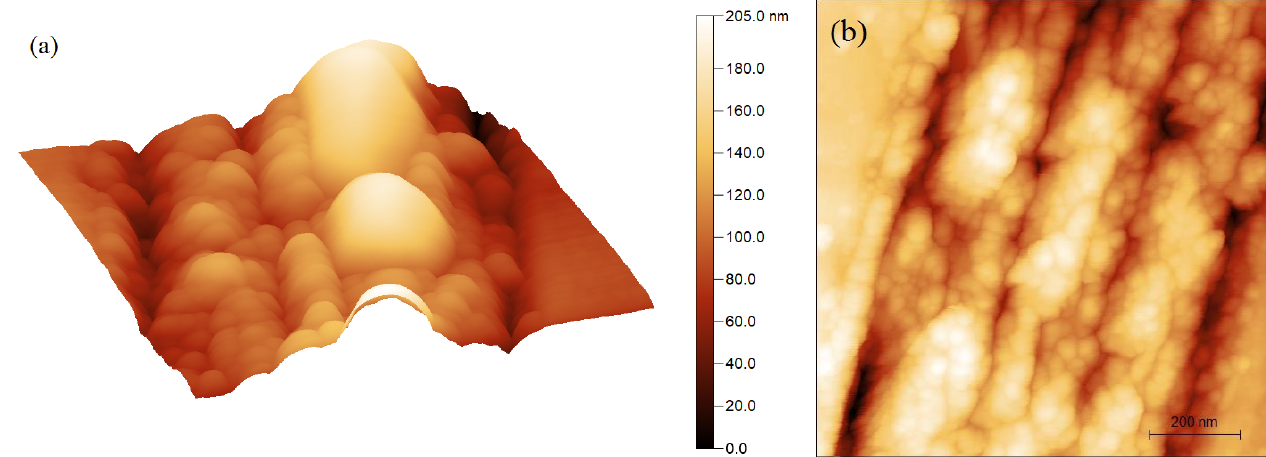
Figure 4. 3D view of top LIPSS shown in Figure 3d showing the roughness of the nanowalls. ( a ) shows a side view taken after the etching as represented in top view in ( b